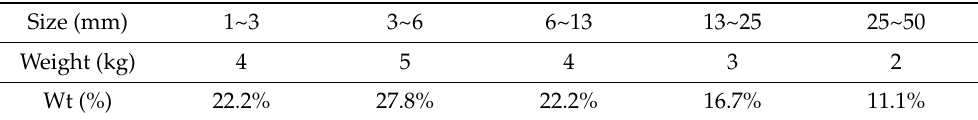
Table 1. Coal particle size fraction before screening.